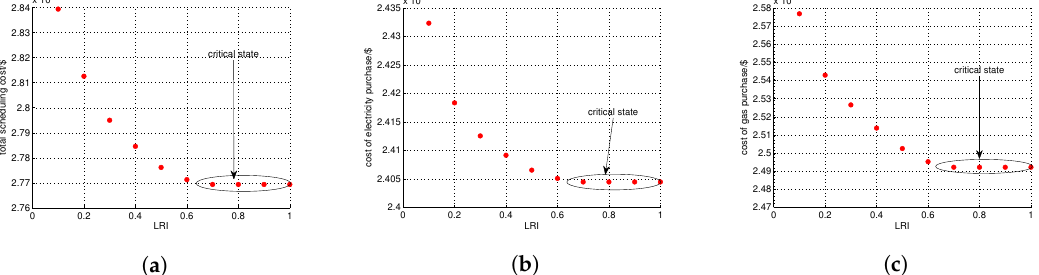
Figure 9. Relation between offline potential-based LRI and optimal scheduling results in Scenario 2. ( a ) The relation between LRI and optimal energy cost. ( b ) The relation between LRI and optimal cost of electricity purchase. ( c ) The relation between LRI and optimal cost of gas purchase.